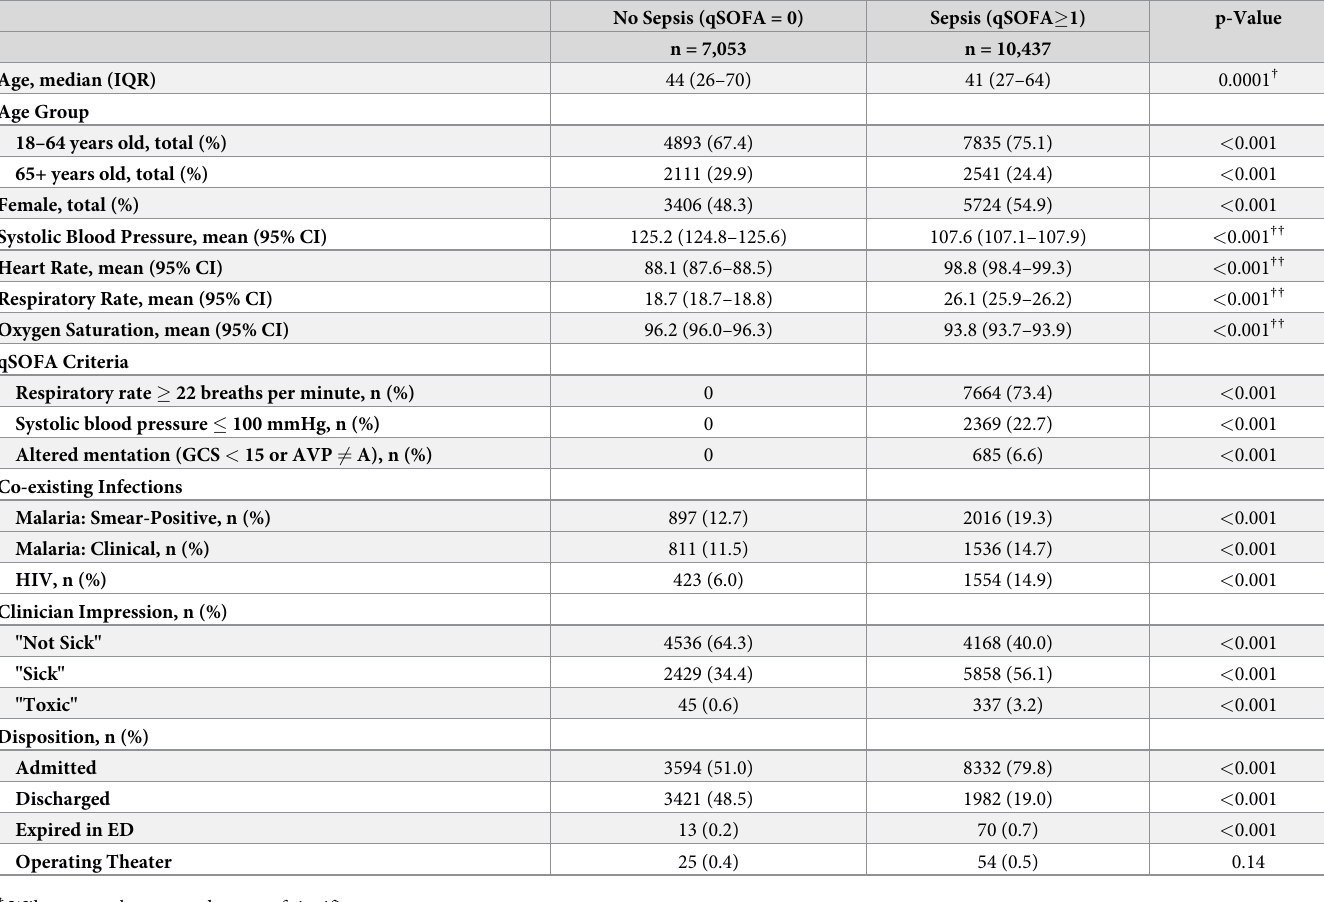
Table 1. Characteristics of non-septic (qSOFA = 0) and septic (qSOFA � 1) emergency unit patients with suspected infections (N =